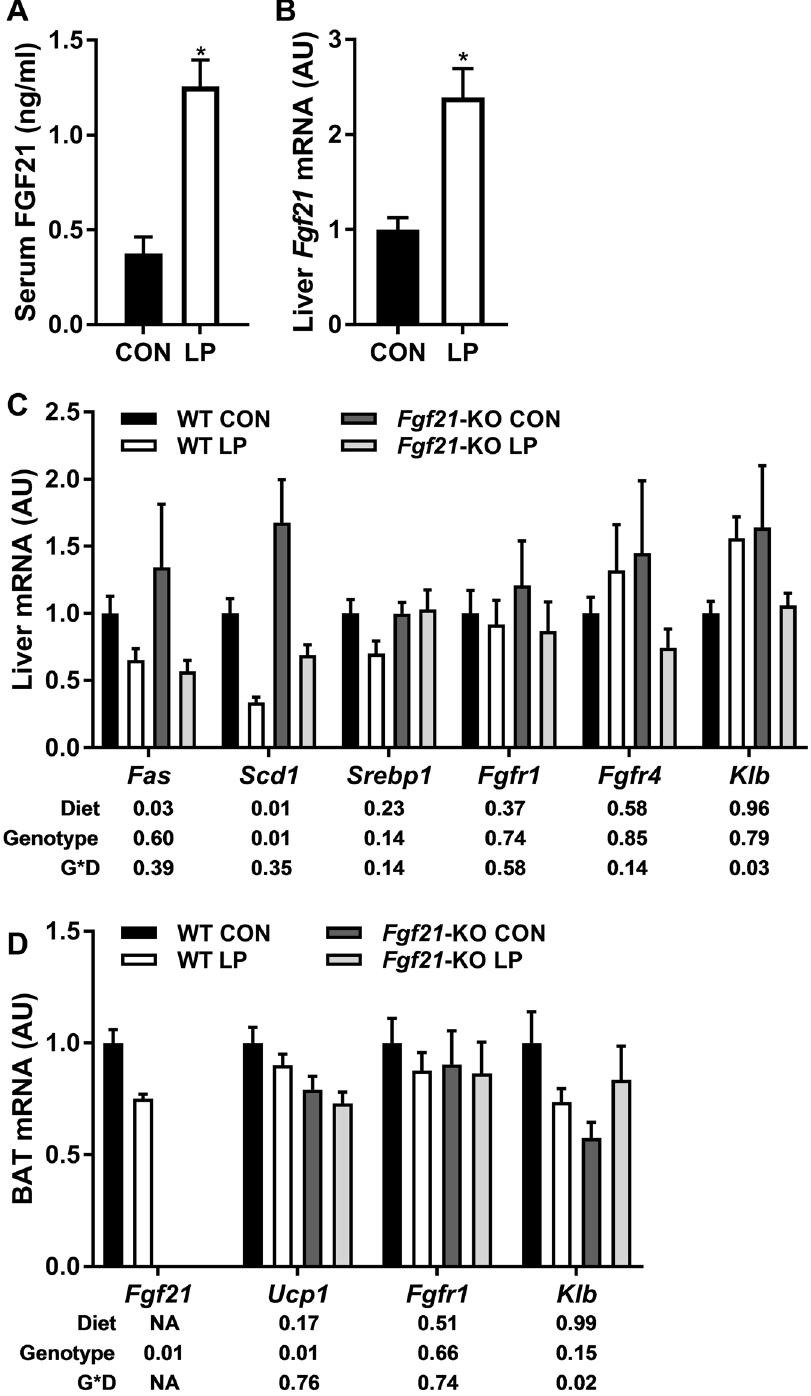
Figure 5. Effect of low protein diet and FGF21 deletion on metabolic endpoints following acute cold stress. WT and Fgf21 -KO mice were placed on LP for 10 days, and on day 10 food was removed and temperature was reduced to 4 °C. Mice were sacrificed after 6hrs at 4 °C, and serum FGF21 ( A ), liver Fgf21 mRNA ( B ), liver ( C ) and BAT ( D ) mRNA expression was measured. 10/group. * P < 0.05 LP vs. respective control. Probability values for the two-way ANOVA main effects of diet and genotype, and their interaction (G * D) are provided below the respective mRNA in C and D